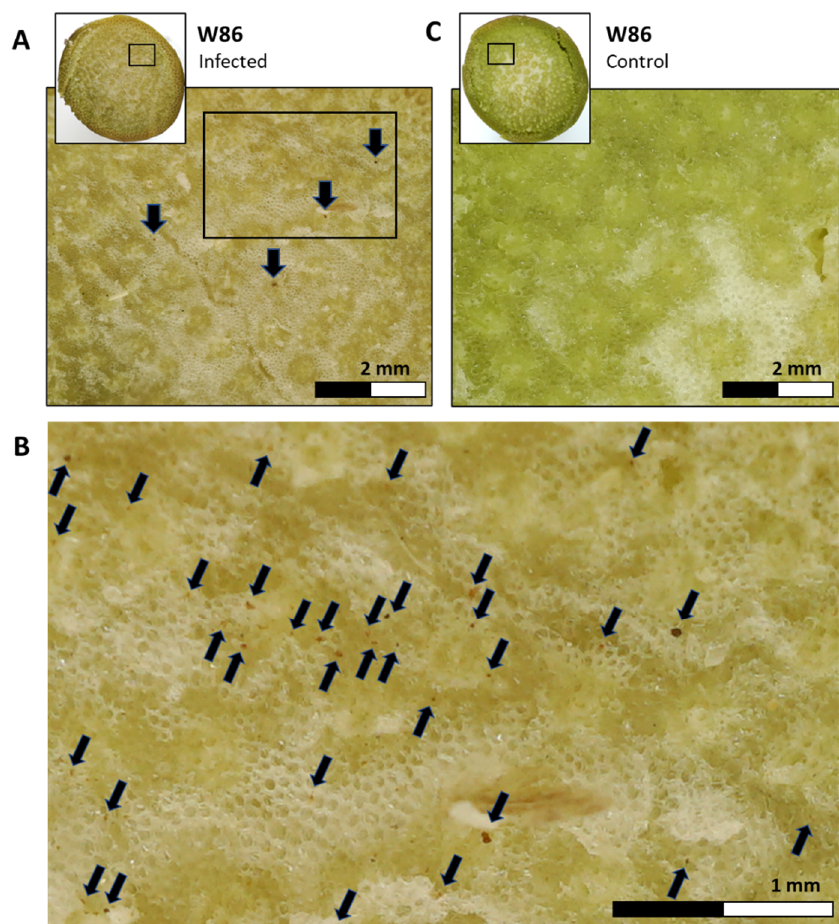
Figure 6. Stem cross-section symptoms in the P32W86 cv. (W86, LWD-susceptible) at the end of the open-air pot experiments (day 101 from sowing, 41 days from fertilization). Cross-section magnification was made of the lower stems (below the first internode) of representative plants from the infection treatment ( A , B ) and the non-inoculated control ( C ). The stalk width was ca. 35 mm in diameter. The magnitude area (black square in the whole stalk cross-section, ( A , C )) wide is 7 mm. The width of the magnitude area in ( B ) is 3.5 mm. Late wilt symptomatic plants revealed a color alteration in the lower stems to a yellow-brown hue and vascular bundle occlusions (marked by arrows). The experimental images from the ground and from the air are shown in Figure